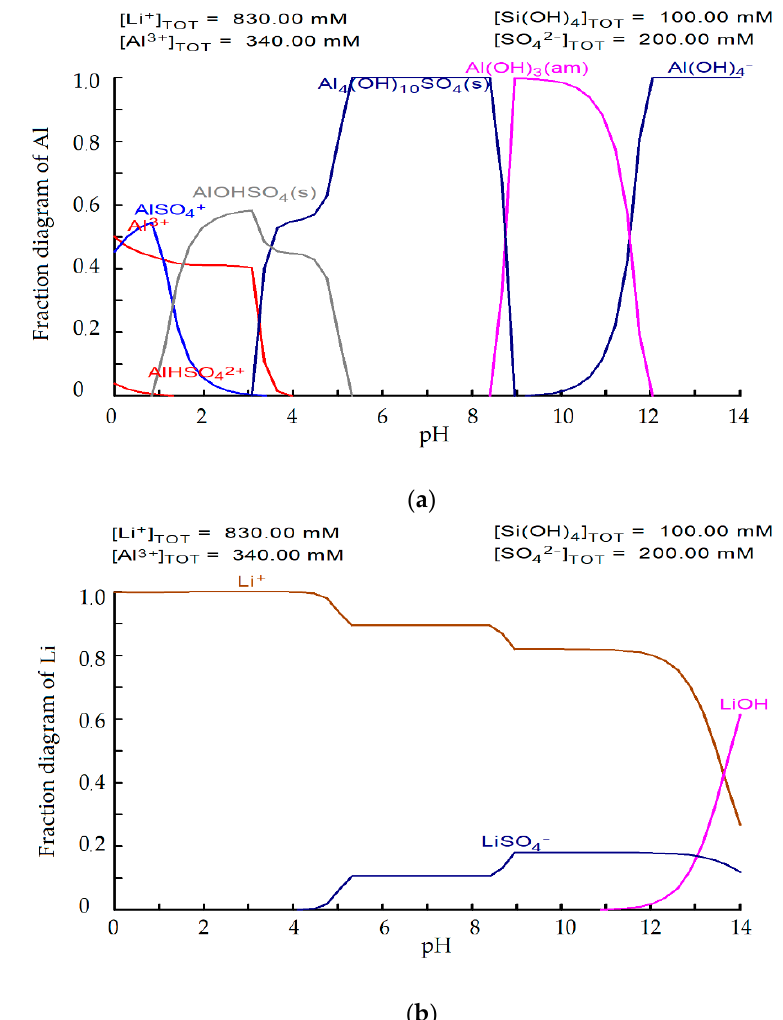
Figure 24. Fraction diagrams of precipitation: ( a ) aluminum; ( b ) lithium.